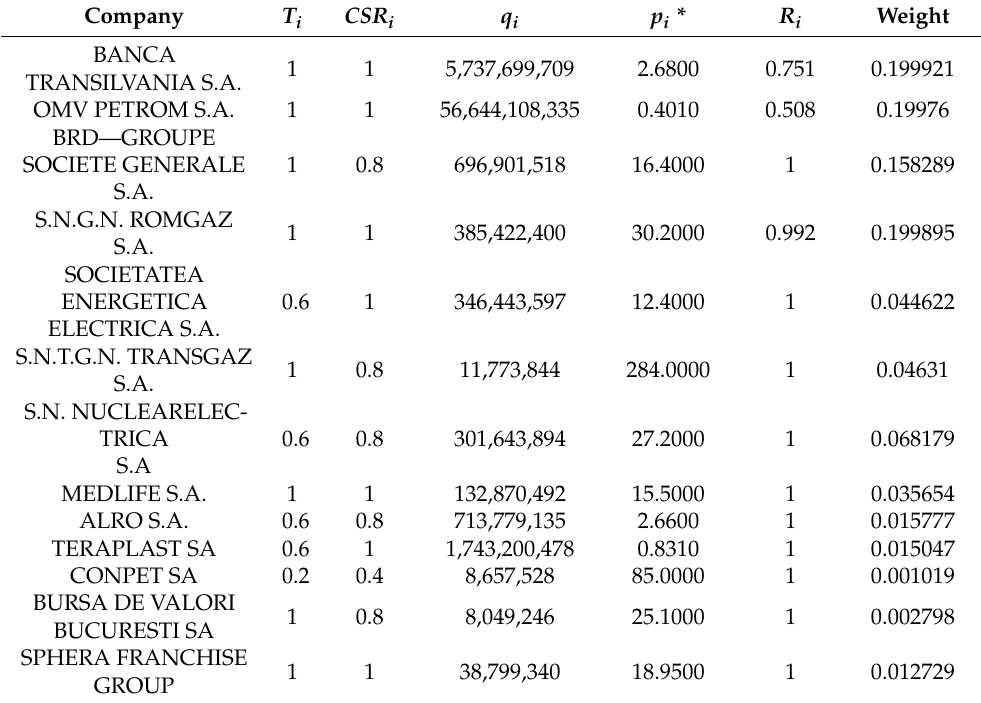
Table 4. Example of initial values for the CSR